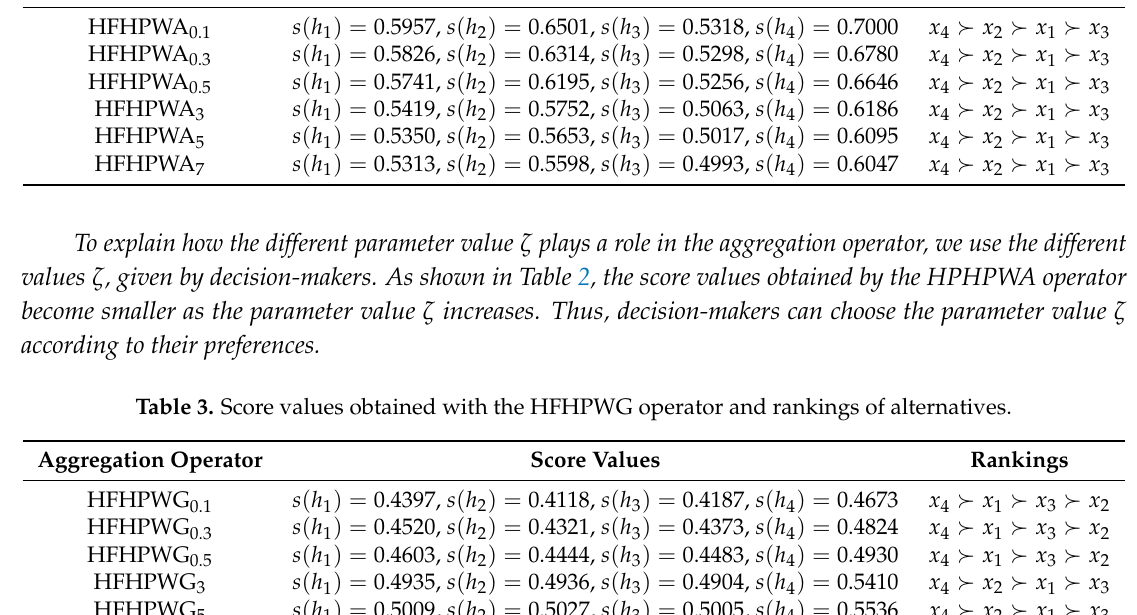
Table 2. Score values obtained with the HFHPWA operator and rankings of alternatives. Aggregation Operator